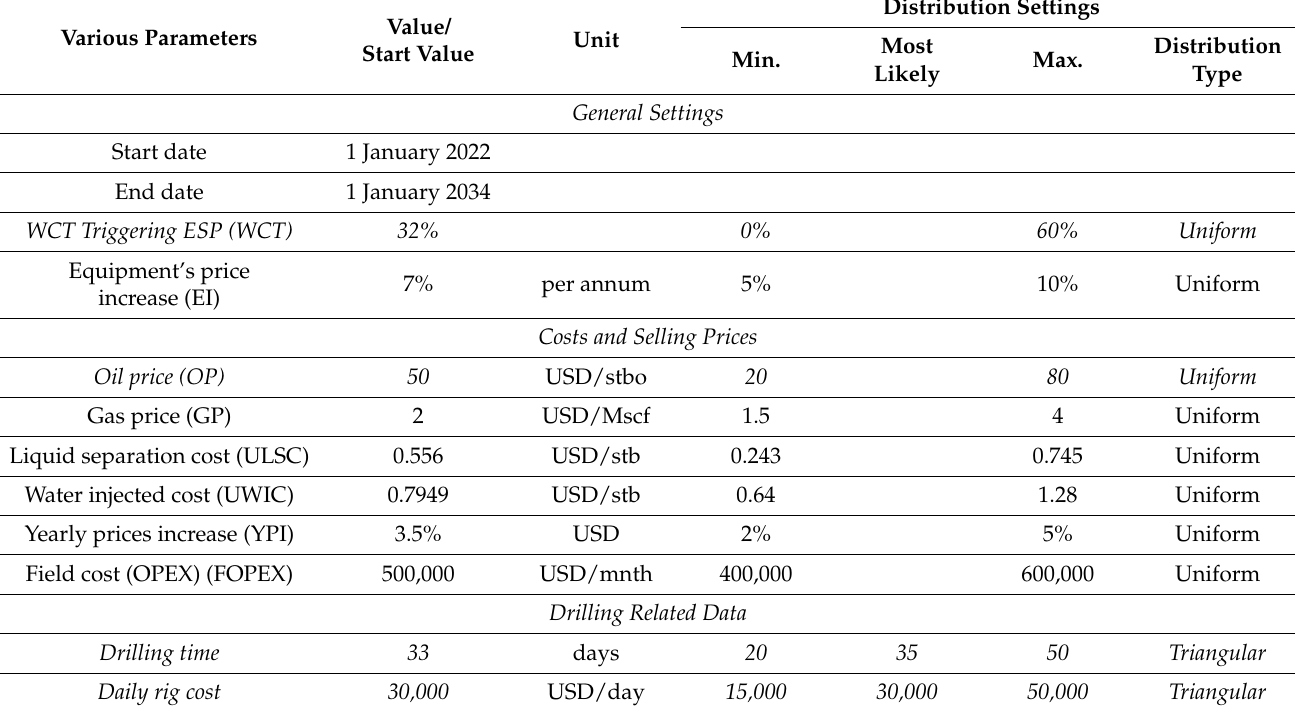
Table 1. Table with Input Variables and Associated Distribution